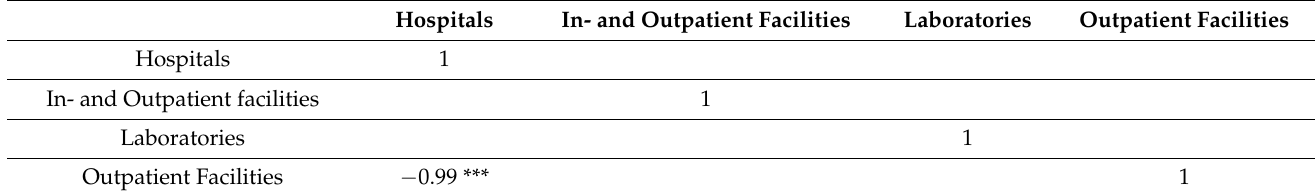
Table 3. Correlation matrix,